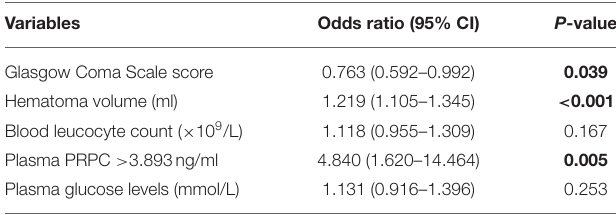
TABLE 7 | Multivariate linear regression analysis of elevated plasma cellular prion protein